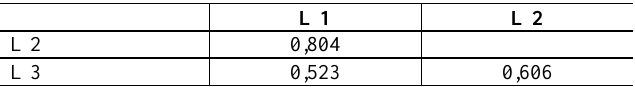
Table 1: Correlation coefficients for Leadership (L )